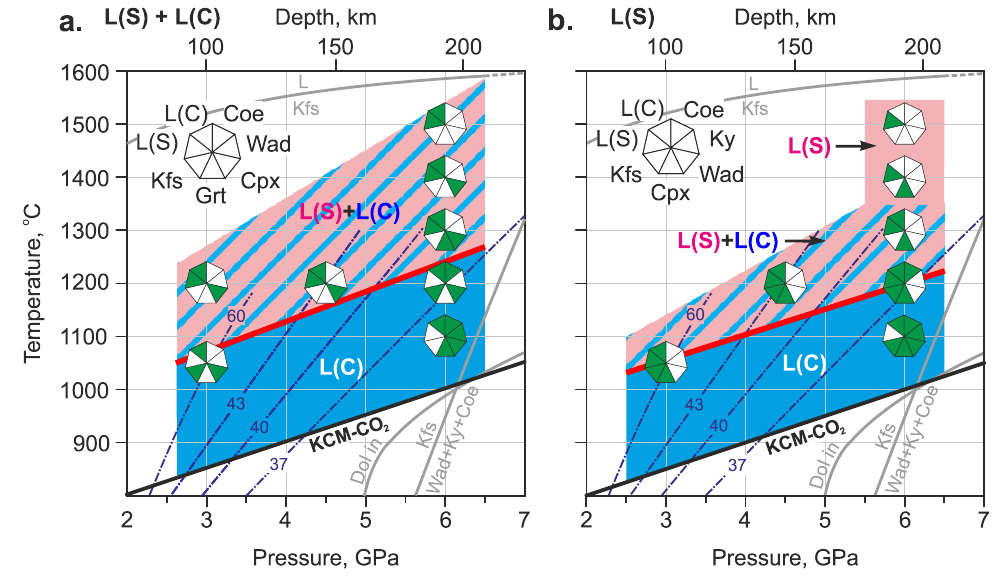
Figure 17. Phase relations in the systems L(S)+L(C) ( a ) and L(S) ( b ). The KCM-CO 2 solidus after [73 – 75]. The shield geotherms with a surface heat flow of 37, 40, and 43 mW/m 2 after [76]. Rift margin geotherm with the heat flow of 60 mW/m 2 after [77].